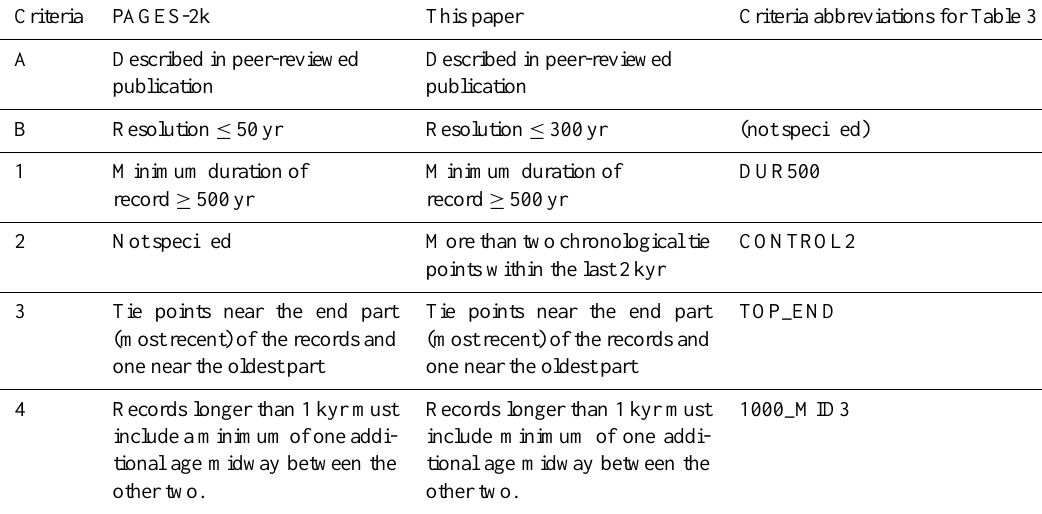
Table 2. Comparison of PAGES-2k criteria with criteria implemented in this